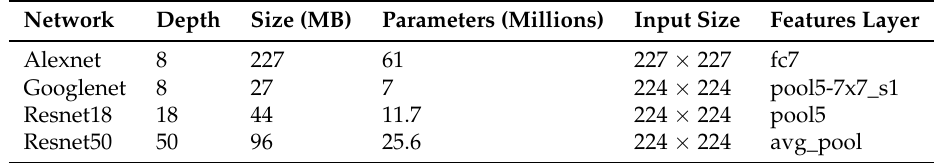
Table 1. Description of the adopted pretrained